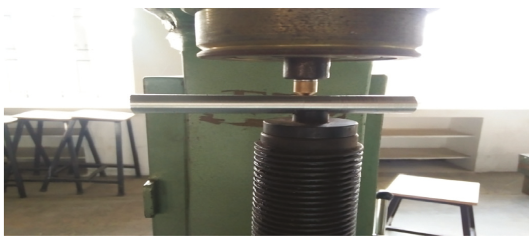
Figure 19: Rockwell hardness testing